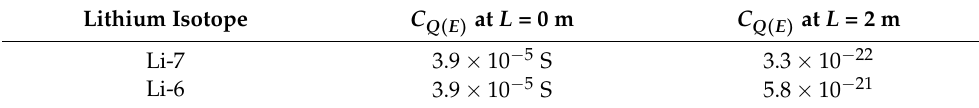
Table 7. The table shows that extracellular lithium isotopes can have a range of quantum conductance of single channel from the value at L = 0 m to the value at L = 2 m according to the setting values in graph (b) of Figure 4.